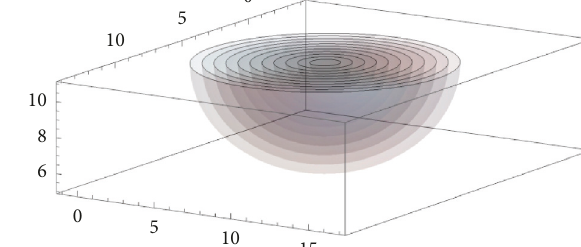
Figure 15: A + B 2 D � 3 D .